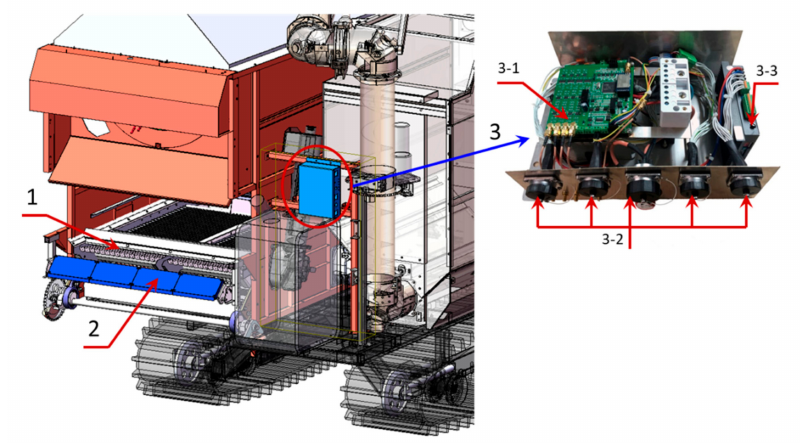
Figure 2. Sensor and control device installation position. ( 1 ) Tail sieve, ( 2 ) Assembled cleaning loss sensor, ( 3 ) Adaptive control device of cleaning loss, ( 3-1 ) Controller, ( 3-2 ) Aviation plug, ( 3-3 ).